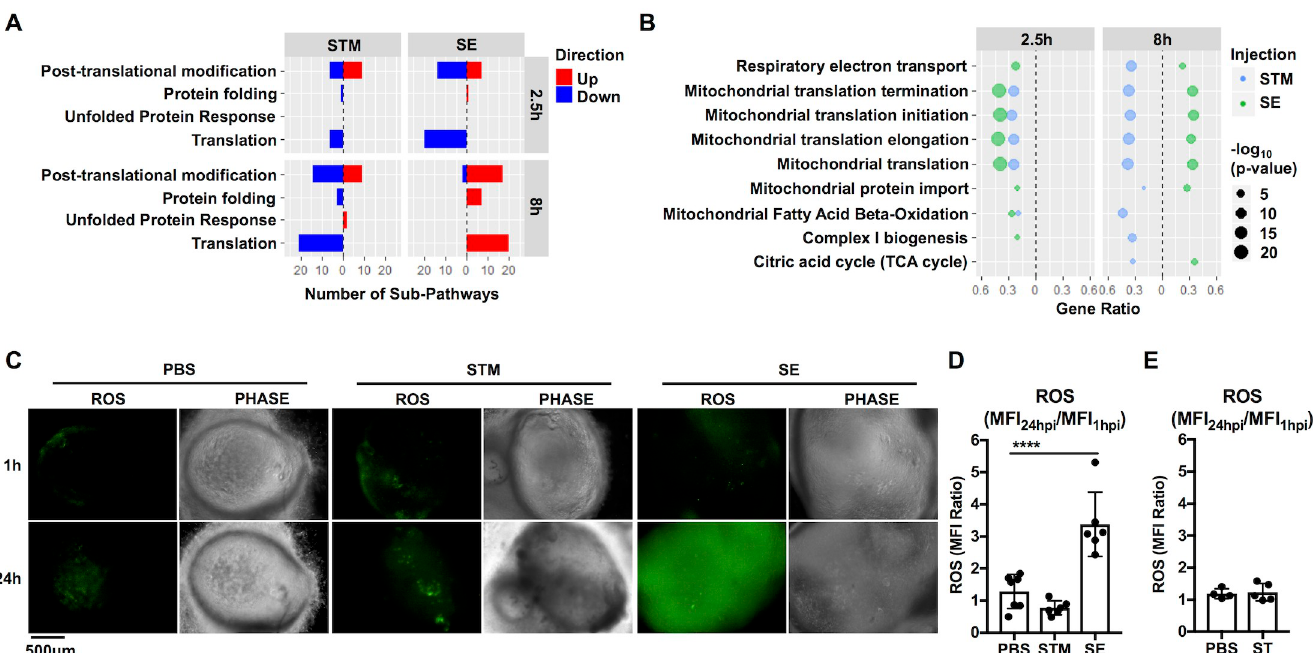
Fig 6. NTS infections inversely regulate changes in mitochondrial-related cellular processes at 8hpi and trigger differential ROS production. (A) Number of significant sub-pathways from the Reactome metabolism of proteins category during NTS infection. Upregulated (red) or downregulated (blue) pathways were identified using ReactomePA. Significant pathways were determined based on P value < 0.05. (B) Dot plot showing significantly enriched mitochondrial metabolism- related pathways in NTS-infected HIOs. Filtered by P value < 0.05. (C) Representative fluorescence images measuring reactive oxygen species (ROS) levels in HIOs by general oxidative stress dye, CM-H 2 DCFDA. (D) Quantitation reactive oxygen species levels of (C) with n � 6 HIOs measuring the ratio of the mean fluorescence intensity (MFI Ratio) at 24h relative to 1hpi. (E) Quantification of reactive oxygen species levels in PBS or ST-infected HIOs at 24h relative to 1h. Error bars represent +/-SD. Statistical significance was determined by one-way ANOVA followed up by Tukey’s multiple comparisons test. ���� < 0.0001.